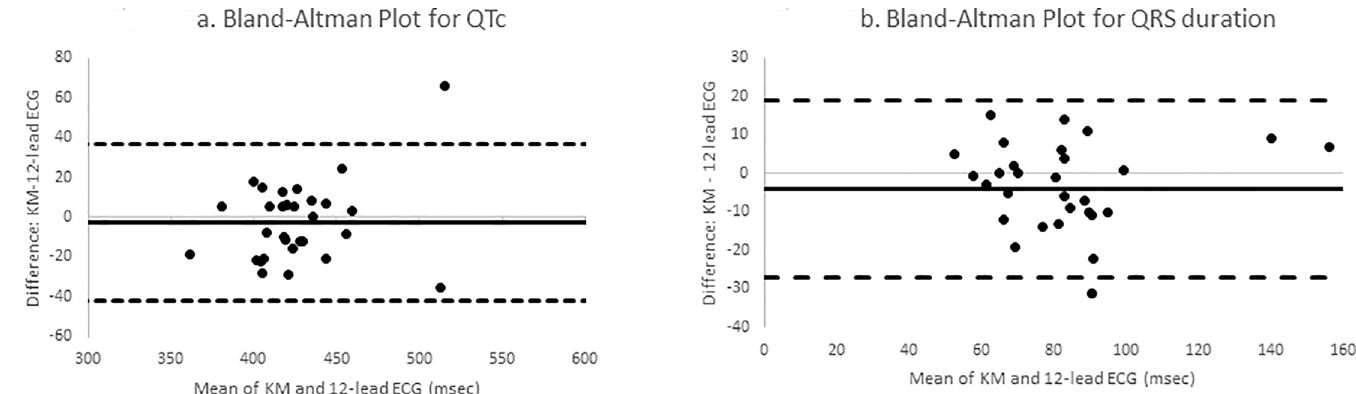
Fig 2. Bland-Altman plots. These Bland Altman plots for QTc (2a) and QRS (2b) demonstrate strong levels of agreement between KM and 12-lead ECG.